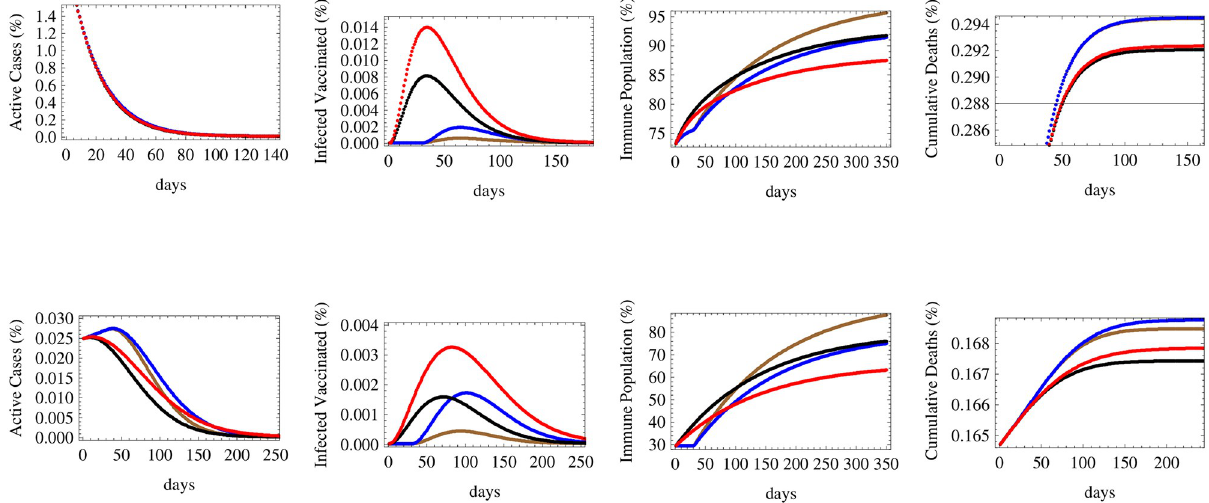
Fig 8. The figure shows the expected relative numbers of active cases, infected vaccinated cases, immune population and cumulative deaths corresponding to a high reproductive rate R = 1.5 with same initial conditions, efficacies and time of initiation as those detailed in Fig 6.